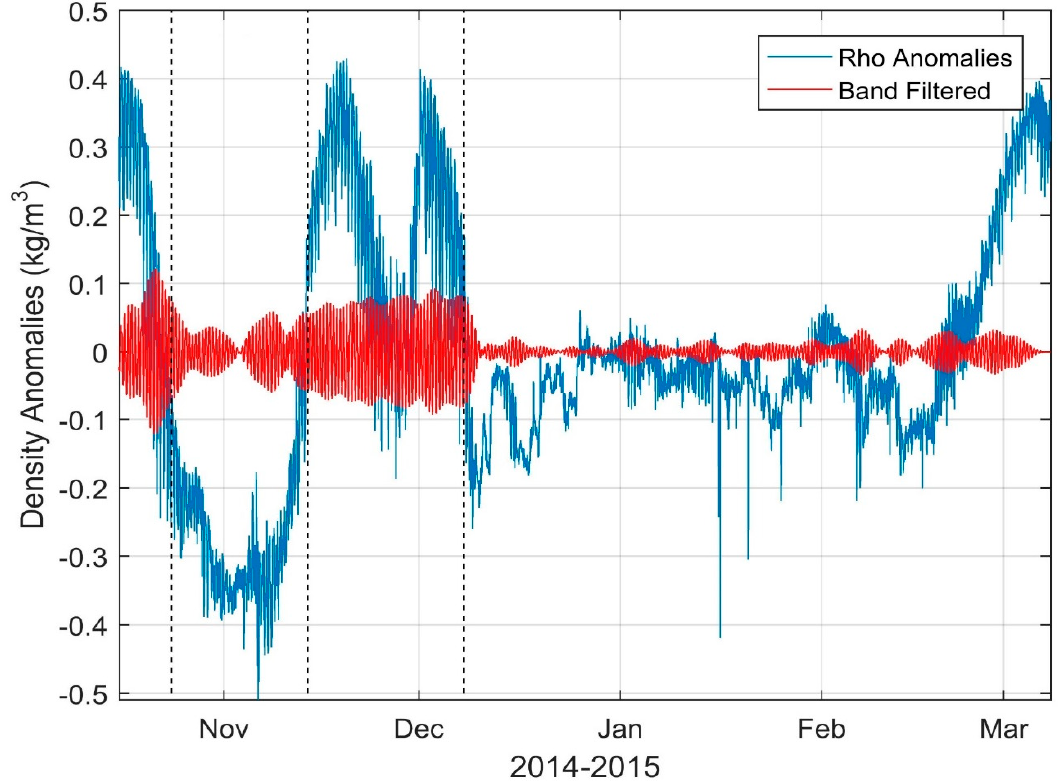
Figure 18. Time series of density (Rho, blue line) anomalies measured by the near-bottom CTD unit. The red line is the band (9–15 h) filtered result.